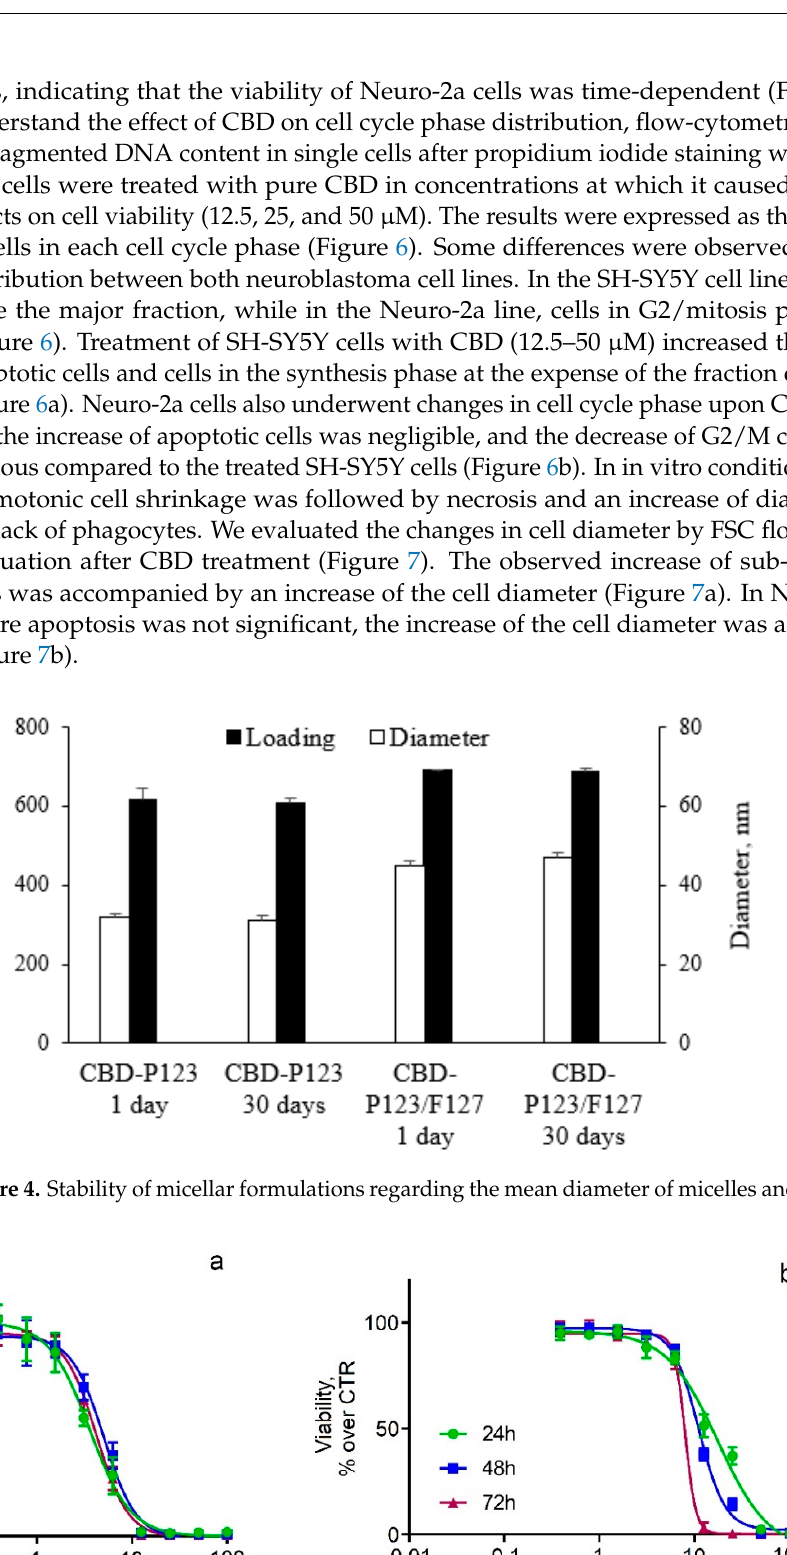
Figure 6. Distribution by cell cycle phase of SH-SY5Y cells ( a ) and Neuro-2a cells ( b ) after 24 h of treatment with different concentrations of pure CBD. Gap 1/quiescent phase (G0/1), synthesis phase (S), gap 2/mitosis phase (G2/M), and apoptotic cells (sub-G0). Values are presented as the percentage of the cell population in studied samples.